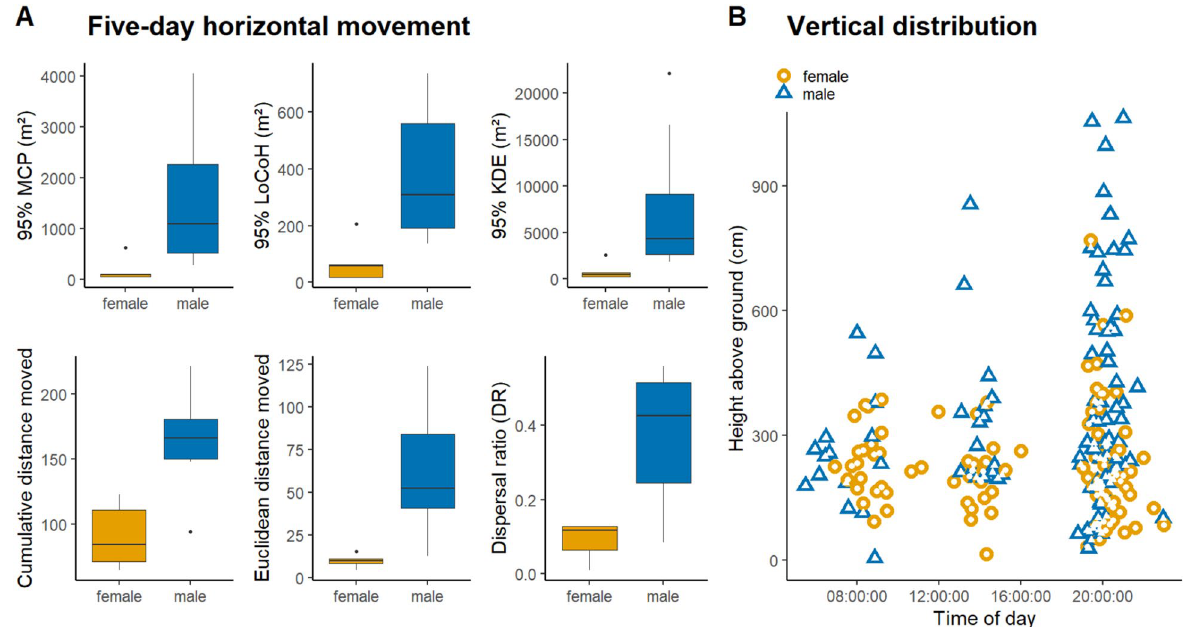
Figure 2. ( A ) Occurrence distribution estimates and other metrics of movement of male (blue) and female (orange) Labord’s chameleons tracked for a time span of 5 consecutive days. Depicted are sex differences in the average areas of the 95% Minimum Convex Polygons (MCP), Local Convex Hull (LoCoH), Kernel Density Estimates (KDE), the cumulative and Euclidian distance moved, as well as the dispersal ratio. ( B ) Vertical distribution of all tracked individuals in the forest